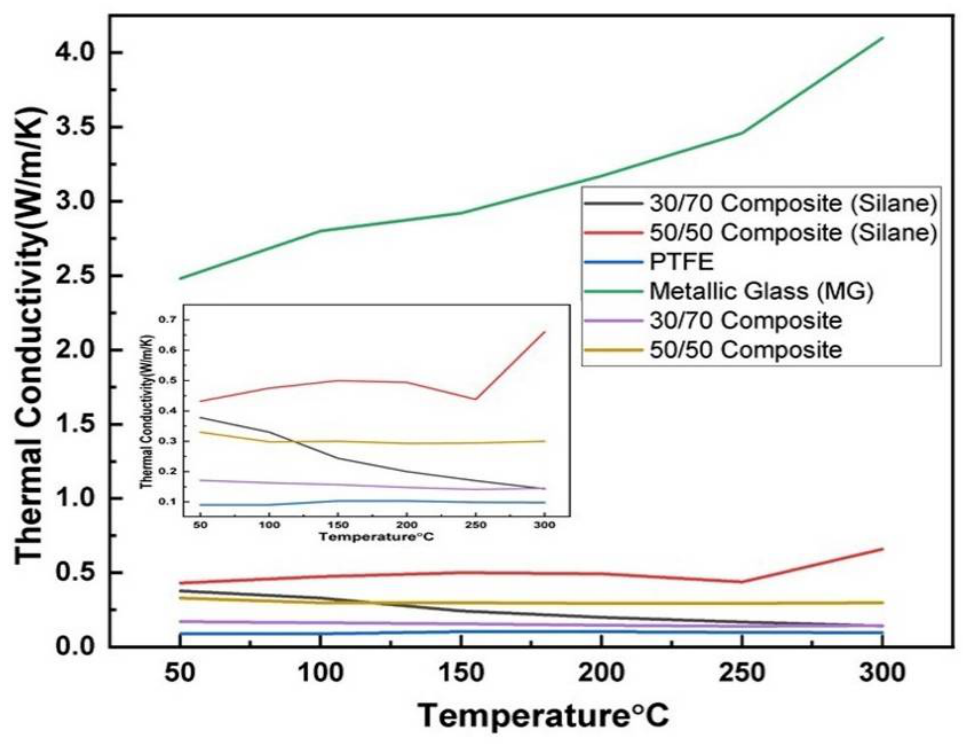
Figure 3. Thermal conductivity of 30/70 composite (silane), 50/50 (silane) composite, PTFE, metallic glass, 30/70 composite and 50/50 composite.